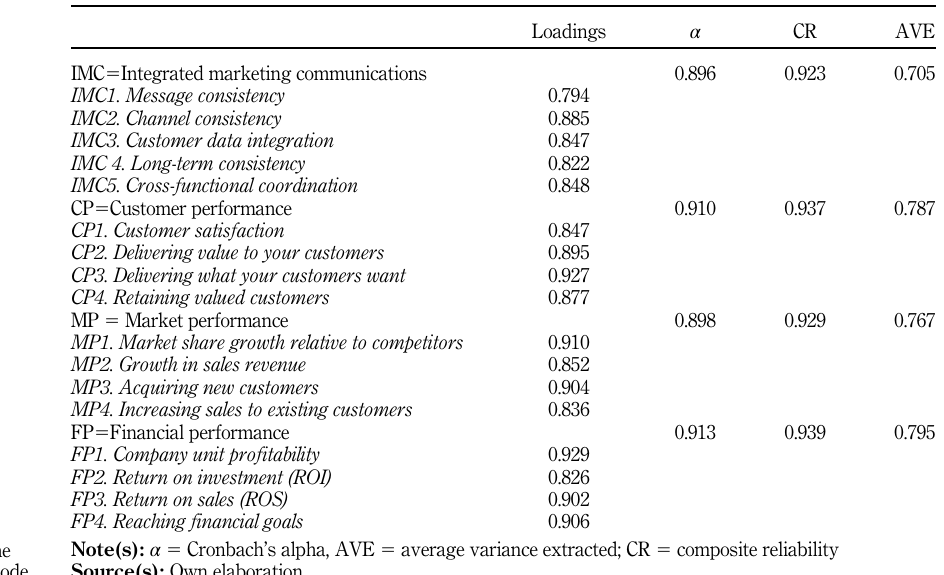
Table 2. Estimation of the measurement